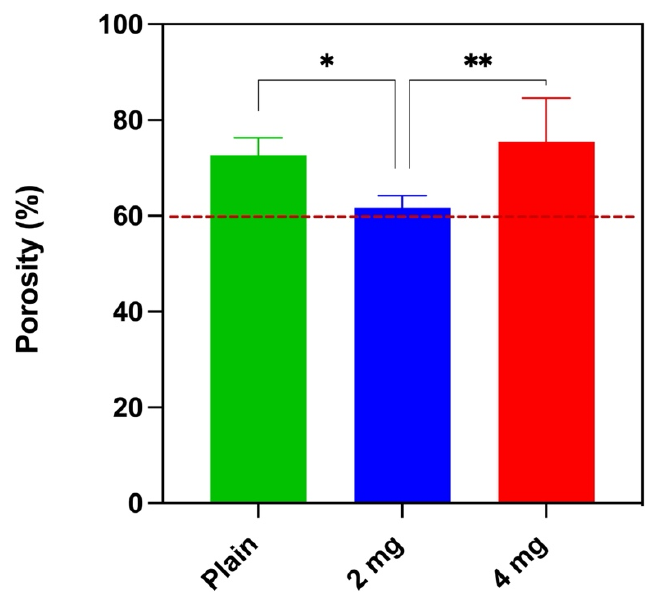
Figure 1. Scaffold porosity. The average % porosity of each scaffold type: (green) PLGA scaffolds, (blue) 2 mg nHA/PLGA scaffolds, and (red) 4 mg nHA/PLGA scaffolds. The average porosity is expressed as the mean ± SD. The data represents five scaffolds per type. * p < 0.05, ** p < 0.01.